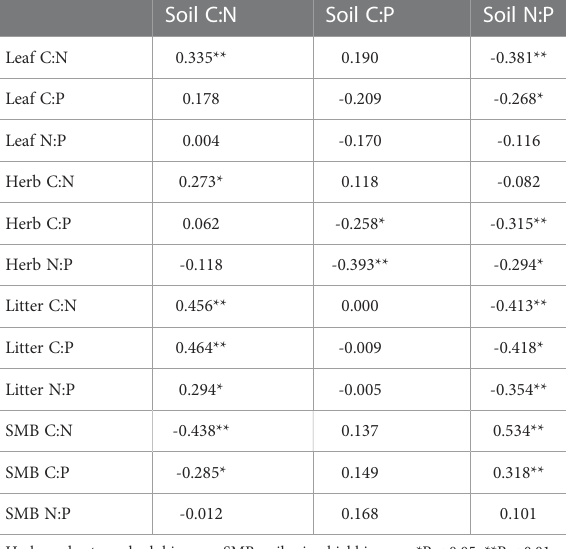
TABLE 3 Correlation coef fi cients between soil ecological stoichiometry and plant, soil microbial biomass ecological stoichiometry.